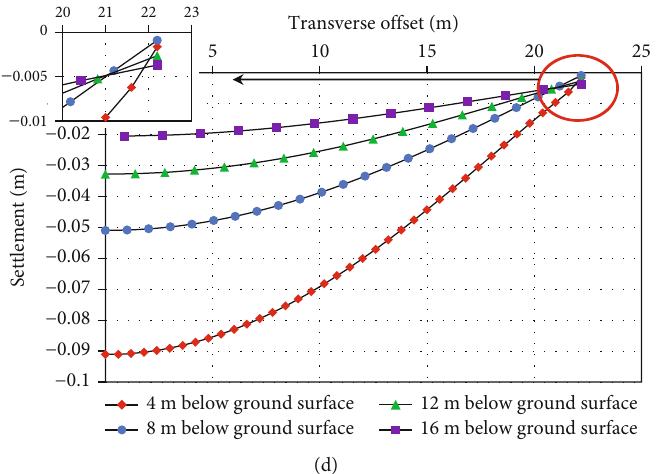
Figure 5: Settlement-transverse o ff set curve of di ff erent underground depths in the soft soil with the replacement thicknesses of (a) 1.5m, (b) 2.0m, (c) 2.5m, and (d) 3.0m.